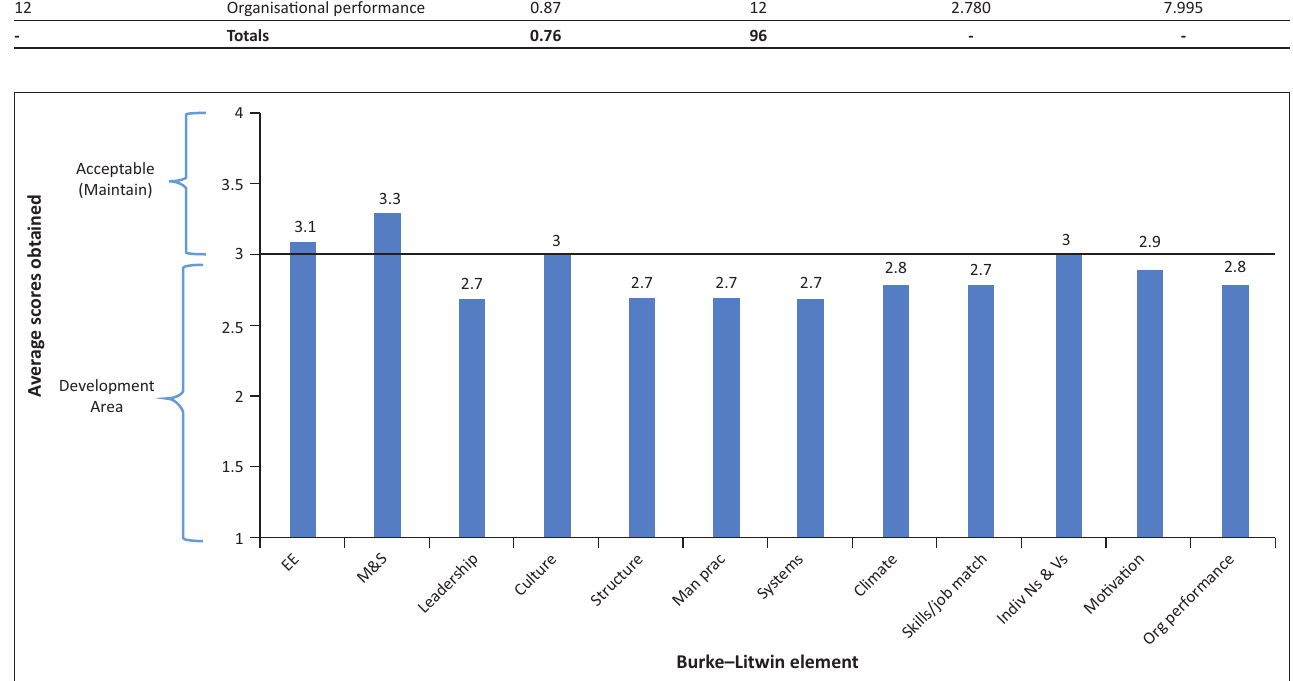
FIGURE 4: Organisational Performance Questionnaire average scores for each Burke–Litwin element ( n = 116).